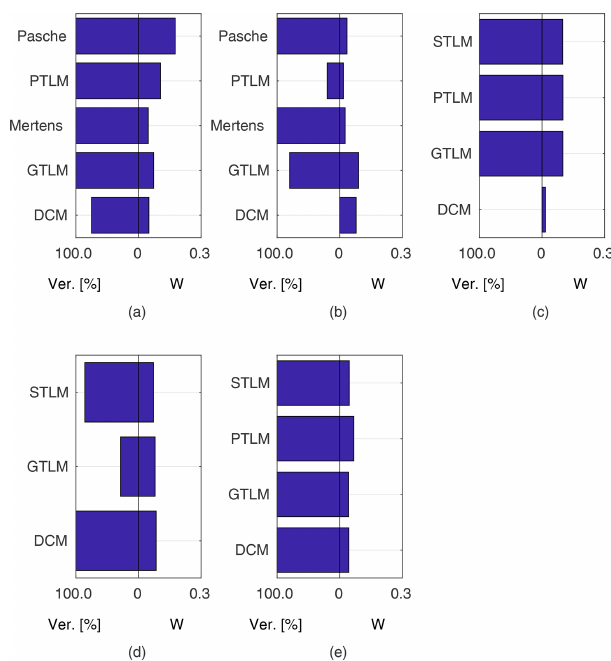
Figure 15. Percentage of verification points for higher flows en- closed within confidence intervals obtained with models identified for five ( m = 5) lower flows (note that only overbank flows were considered): (a) flume experiment, case 1 ( M = 9); (b) flume ex- periment, case 2 ( M = 10); (c) Ritobacken, spring 2011 ( M = 6); (d) Ritobacken, autumn 2011 ( M = 12); (e) Ritobacken, spring 2012 ( M =